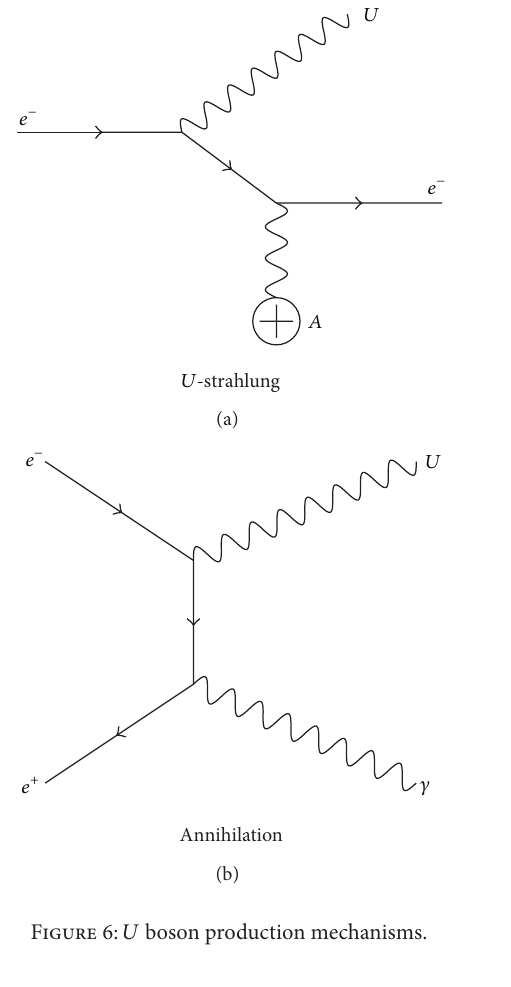
Figure 6: 𝑈 boson production mechanisms.